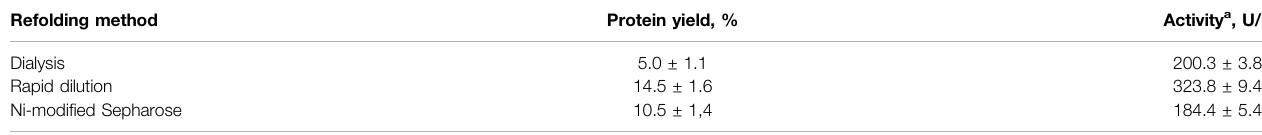
TABLE 1 | Yield and speci fi c activity of the refolded full-length chitinase from D. capensis (Chit19) obtained using various refolding methods. Refolding method